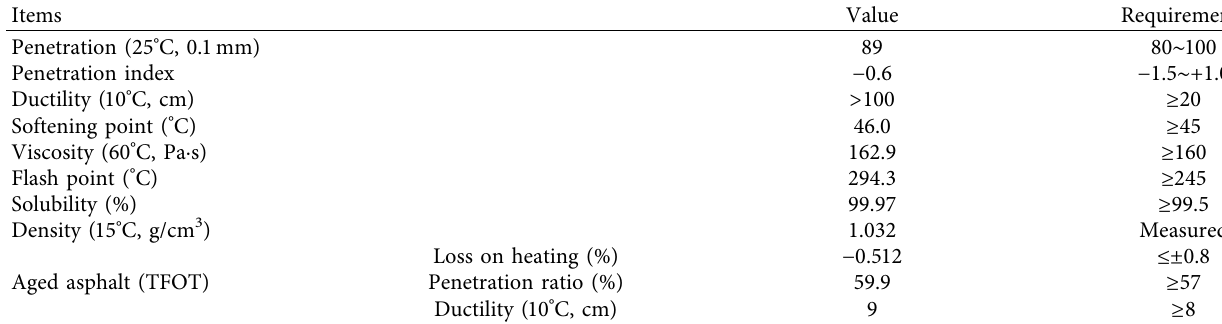
Table 1: The basic properties of SK 90 # virgin asphalt.